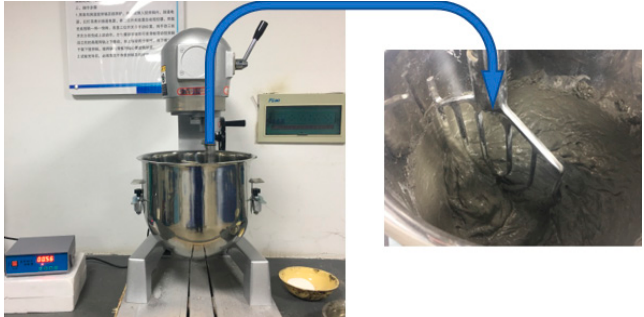
Figure 2. Grading curve of the superfine sand.